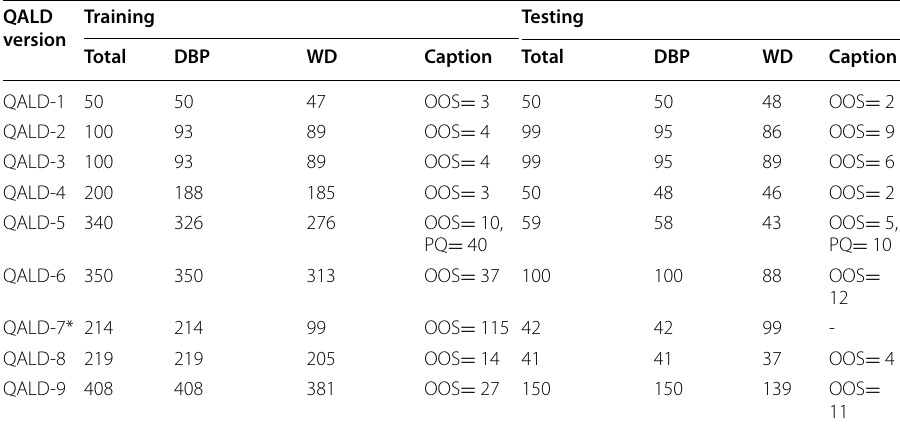
Table 2 Query distribution of QALD series and its translation over